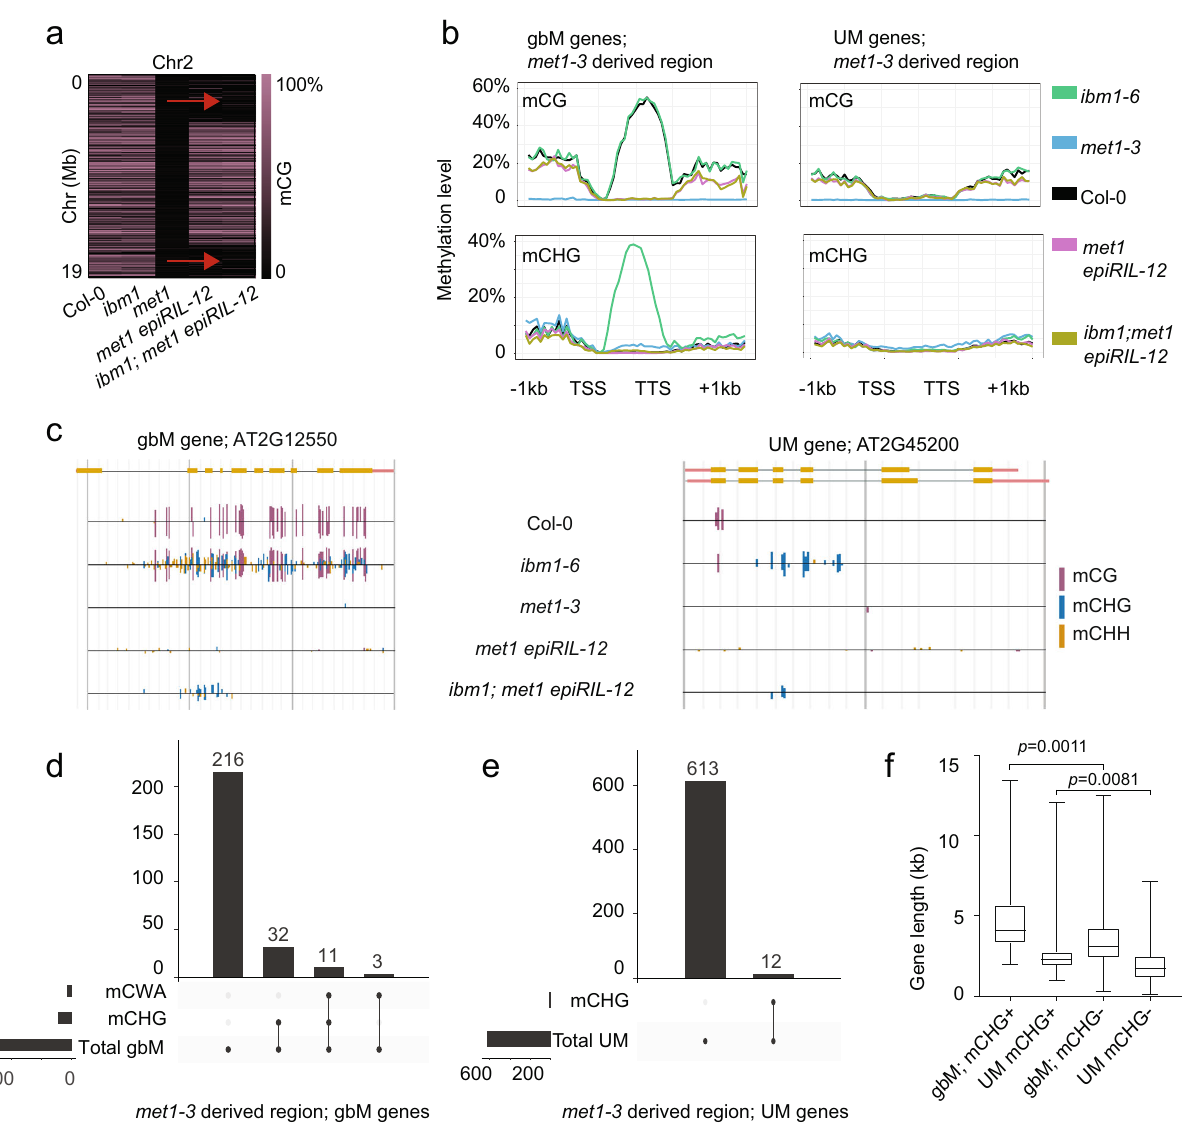
Fig. 5 Mutations in ibm1 lead to ectopic methylation preferentially in genes that previously possessed gbM. a A schematic showing regions that inherited mCG from the met1 epiRIL-12 parent or the ibm1-6 parent on Chromosome 2 ( Col-0, ibm1-6 and met1-3 are shown as controls). Purple to black colors show the mCG percentage of genes that possess gbM in Col-0 from 100% to 0%, respectively. Red arrows indicate a region in ibm1; met1 epiRIL-12 derived from the original met1-3 parent. b DNA methylation plot of gbM and UM genes including 1kb up and downstream for indicated genotypes and methylation contexts. Depicted regions shown are derived from met1-3 . TSS: Transcription Start Site. TTS: Transcription Termination Site. c Genome browser examples of gbM and UM genes from met1-3 derived region of the met1 epiRIL-12 genotypes. d and e The number of gbM and UM genes that gained mCHG, mCWA or non-mCWA for in the met1-3 derived region of ibm1; met1 epiRIL-12 . Vertical bar plot shows count of overlapping genes between different methylation contexts. Horizontal bar plot shows count of speci fi c type of genes. f Gene length distribution of genes that gained mCHG in gbM and UM genes derived from the met1-3 region of ibm1; met1 epiRIL-12 . N = 43, 12, 219, and 613 biologically independent samples for four groups from left to right. Gain is depicted by ‘ + ’ and no gain is depicted by ‘ - ’ . p -value is generated by two-sided student t -test. Box plots show a median center line, the lower and upper hinges are the fi rst and third quartiles. Whiskers represent 1.5x the interquartile range. Source data underlying Figs. 5b and 5f are provided as a Source Data fi